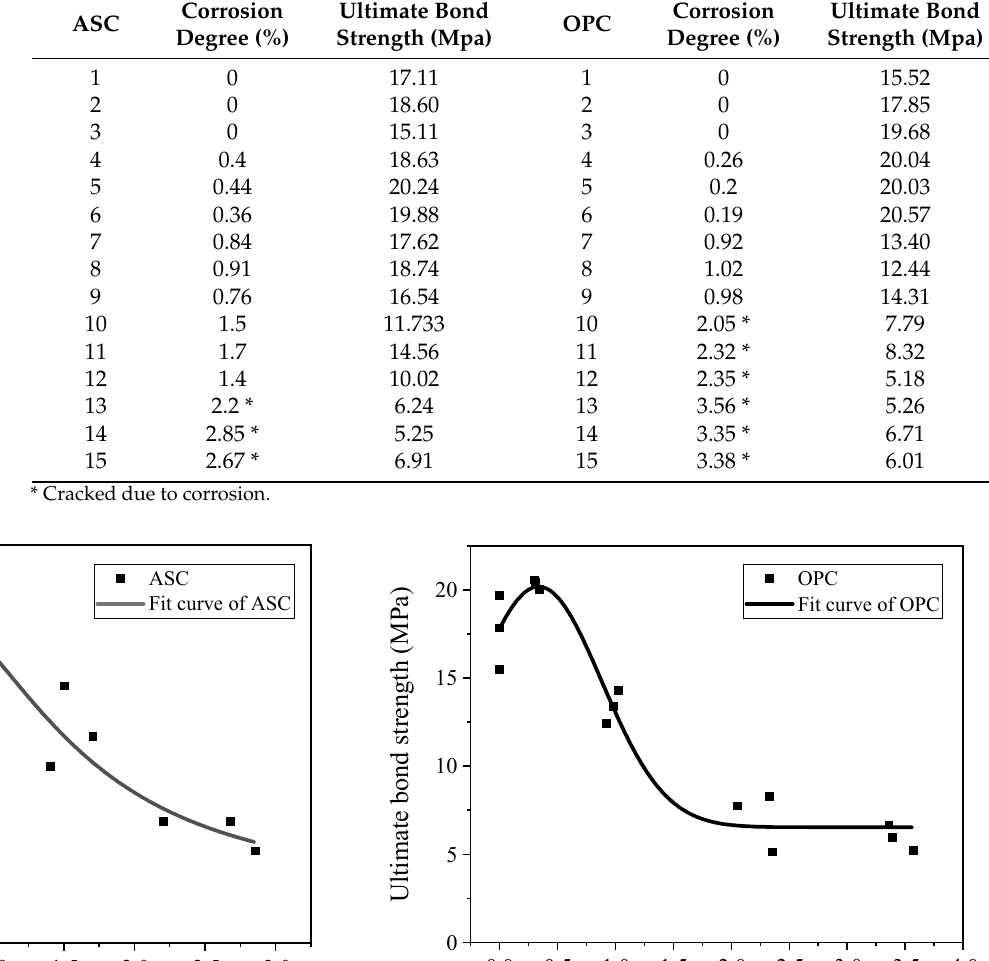
Table 6. Corrosion degree and ultimate bond strength of OPC.